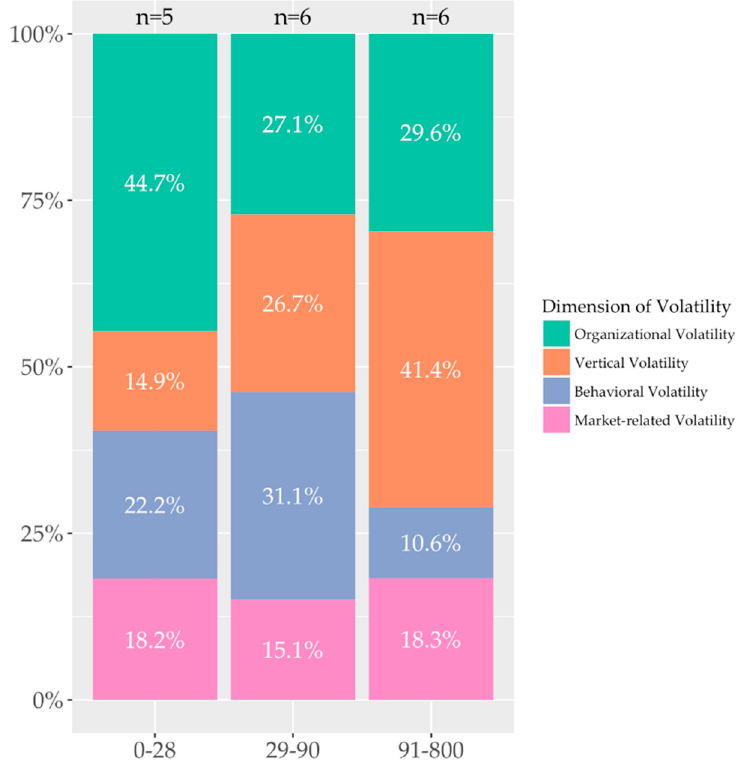
Figure 3. Impact of SCV dimensions on SCV analyzed by length of lead time (in days).